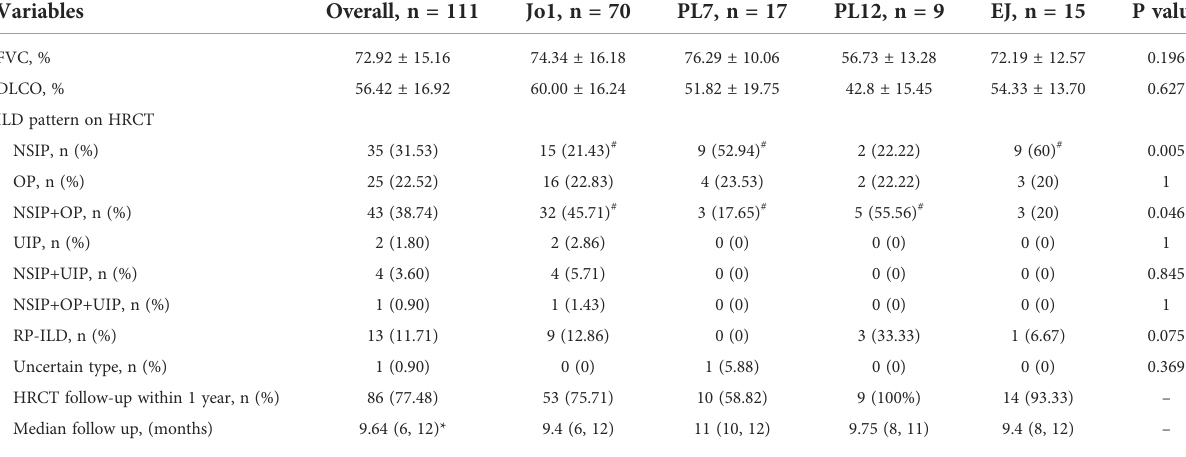
TABLE 3 Comparison of pulmonary function test and imaging features of patients with